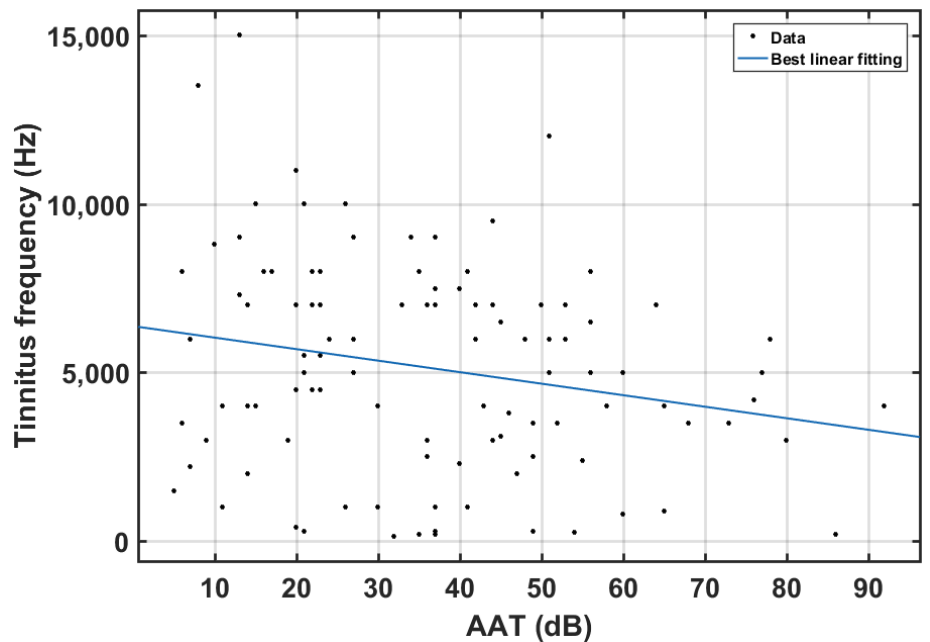
Figure 4. Scatter plot of tinnitus frequency versus AAT for the decompensated subgroup.